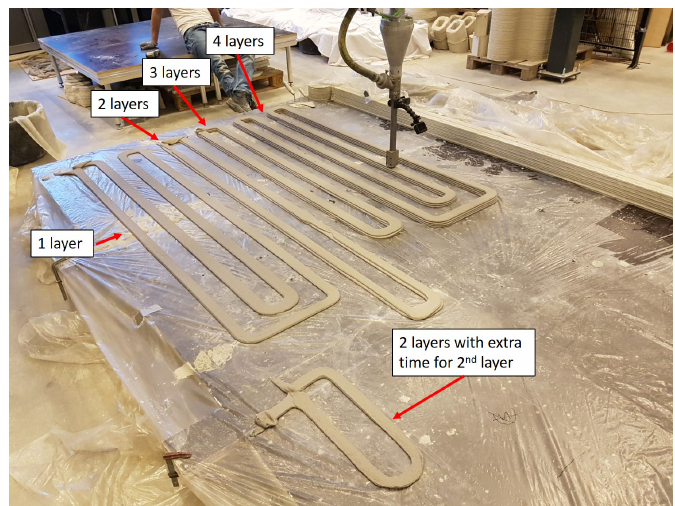
Figure 1. Printing table with final printed elements with one, two, three, and four